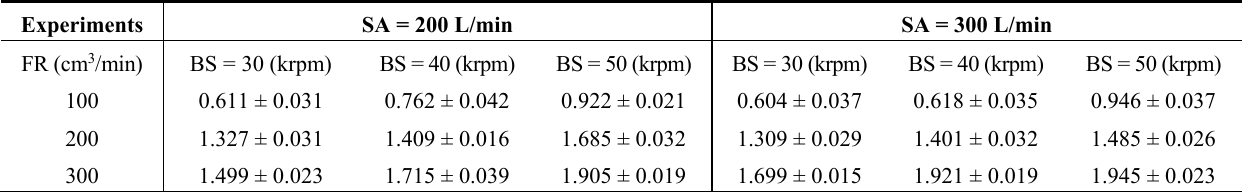
Table A2. Total evaporation (cm 3 /s) for various values of bell speed, flow rate and shaping air.